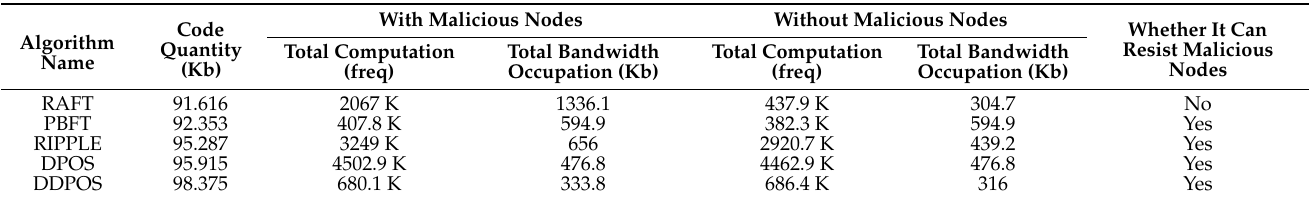
Table 2. The performance comparison of the five